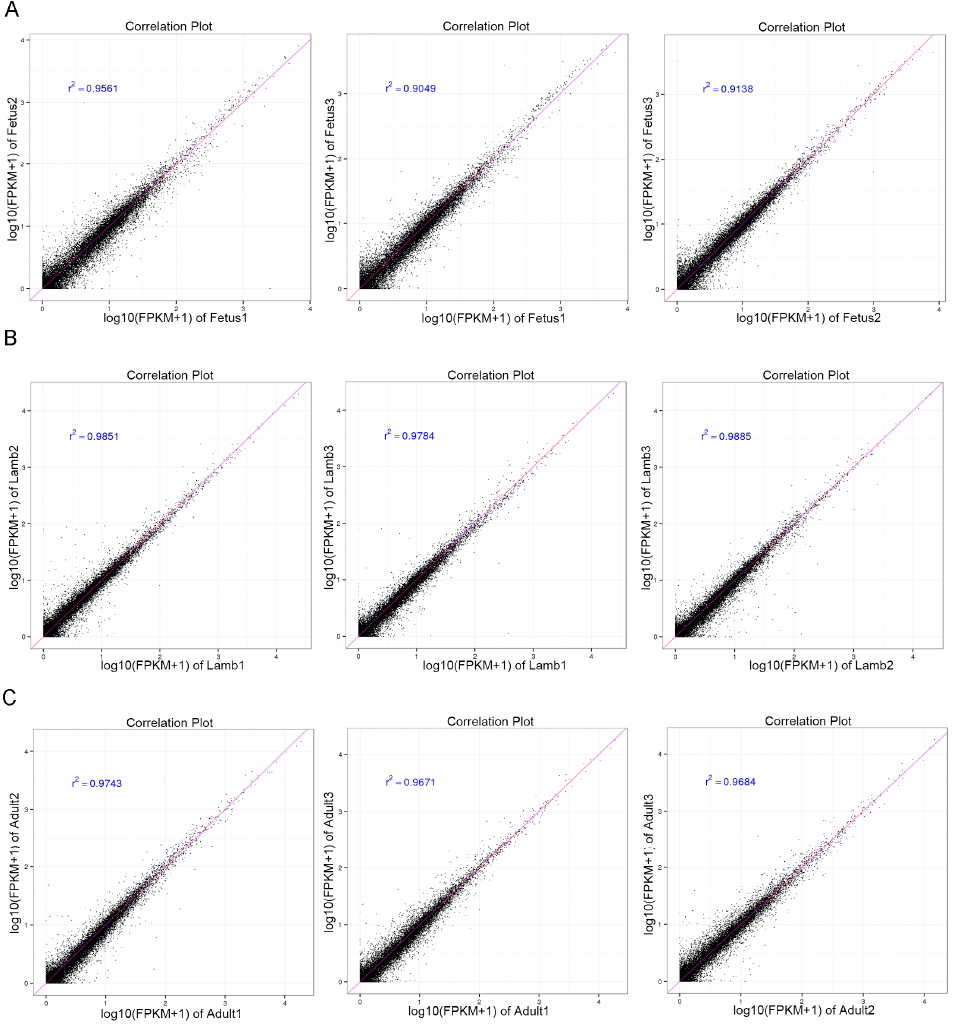
Figure 3. The correlation coefficients analysis between replicates in each group. ( A ) The correlation coefficients between fetus 1, fetus 2, and fetus 3. ( B ) The correlation coefficients between lamb 1, lamb 2, and lamb 3. ( C ) The correlation coefficients between adult 1, adult 2, and adult